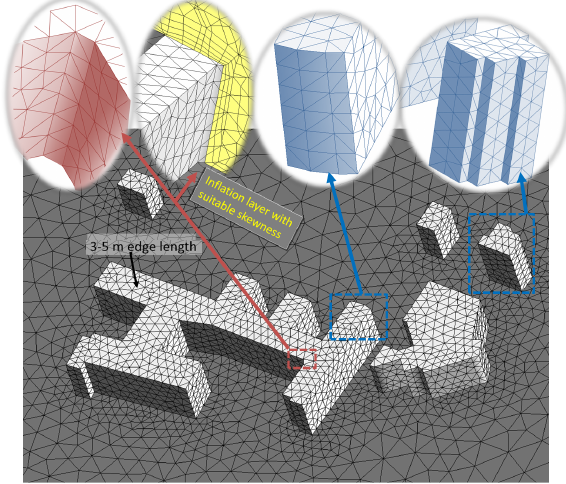
Figure 6. Simplified geometry (sweep-plane algorithm, Sec. 3): Boundary mesh of buildings. Suitable mesh with edges length ≥ 2 m (blue and red). Cross-section with suitable inflation layer (yellow).